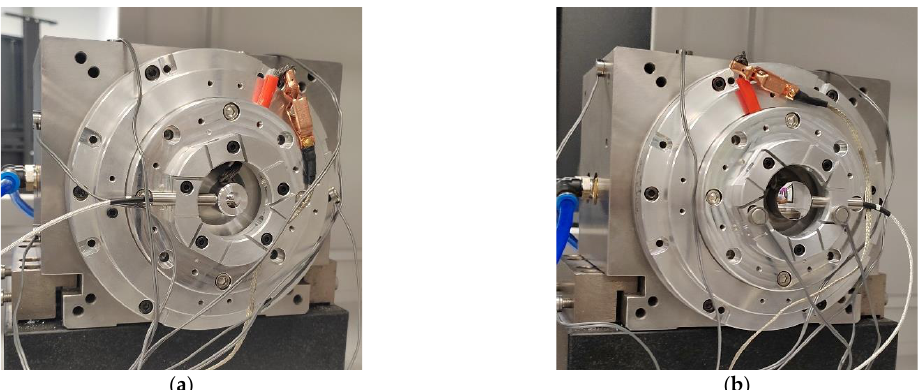
( d ) Figure 9. Detailed steps of radial error measurement using three-point method: ( a ) step 1: mounting of standard workpiece, ( b ) step 2: rough adjustment of standard workpiece, ( c ) step 3: fine adjust- ment of standard workpiece, ( d ) step 4: mounting fixture and sensor probes. 4.2. Comparative Experiment of the Results The comparative experiment is performed based on the Donaldson reversal method to validate the results measured by the in situ measurement and evaluation system. The spindle analyzer developed by Lion Precision and self-designed experimental equipment